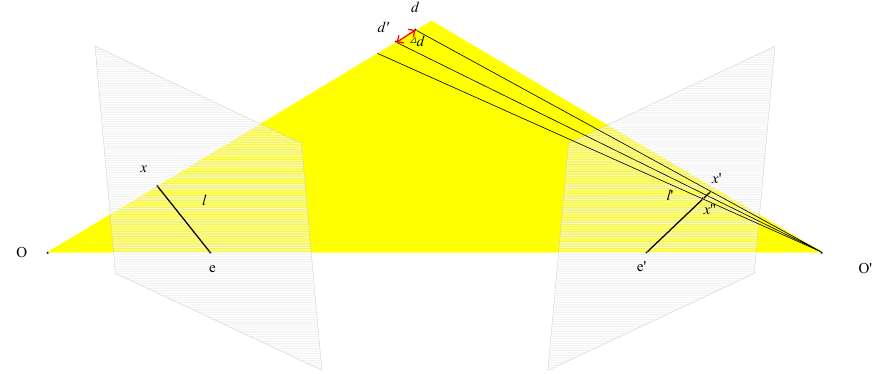
Figure 3. Calculation method of dynamic interval d .